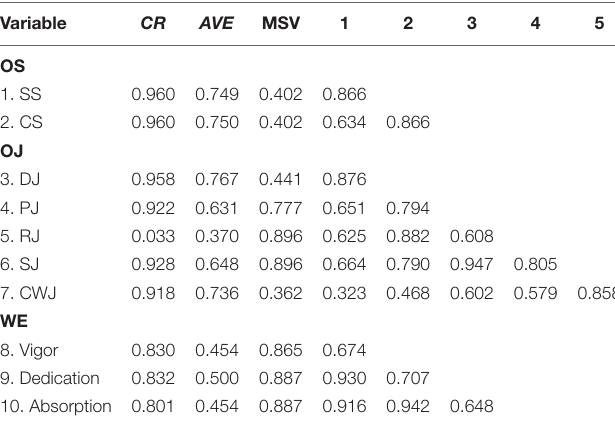
TABLE 5 | CR, AVE, MSV, and inter-scale correlations for study